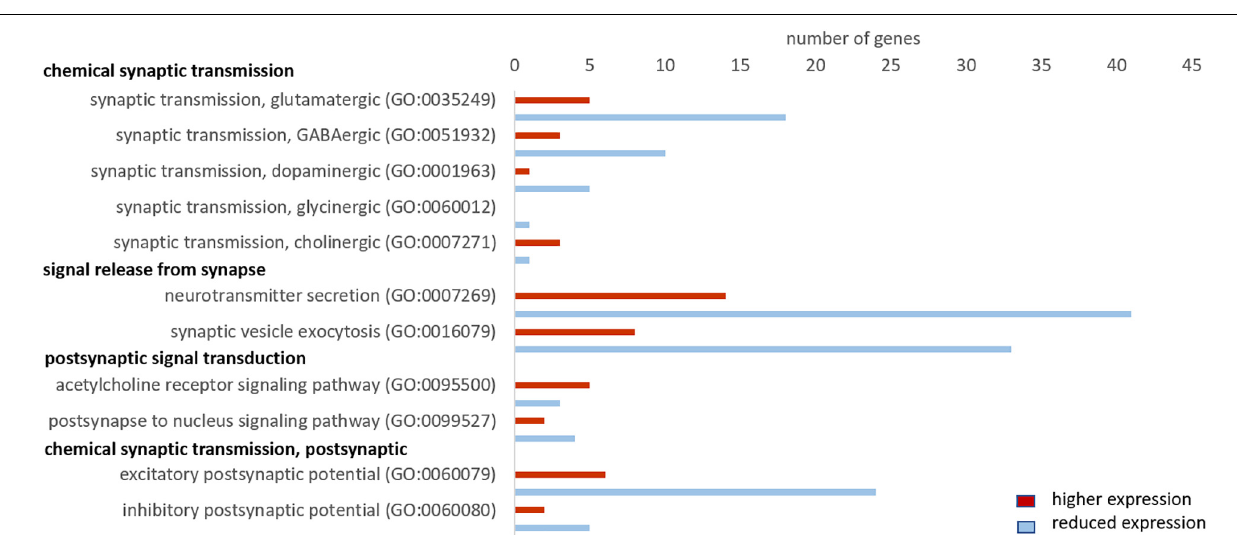
neurons show adaptations in their aerobic metabolism. The GO analysis revealed that genes related to mitochondria organization and function were more highly expressed in the hooded seal